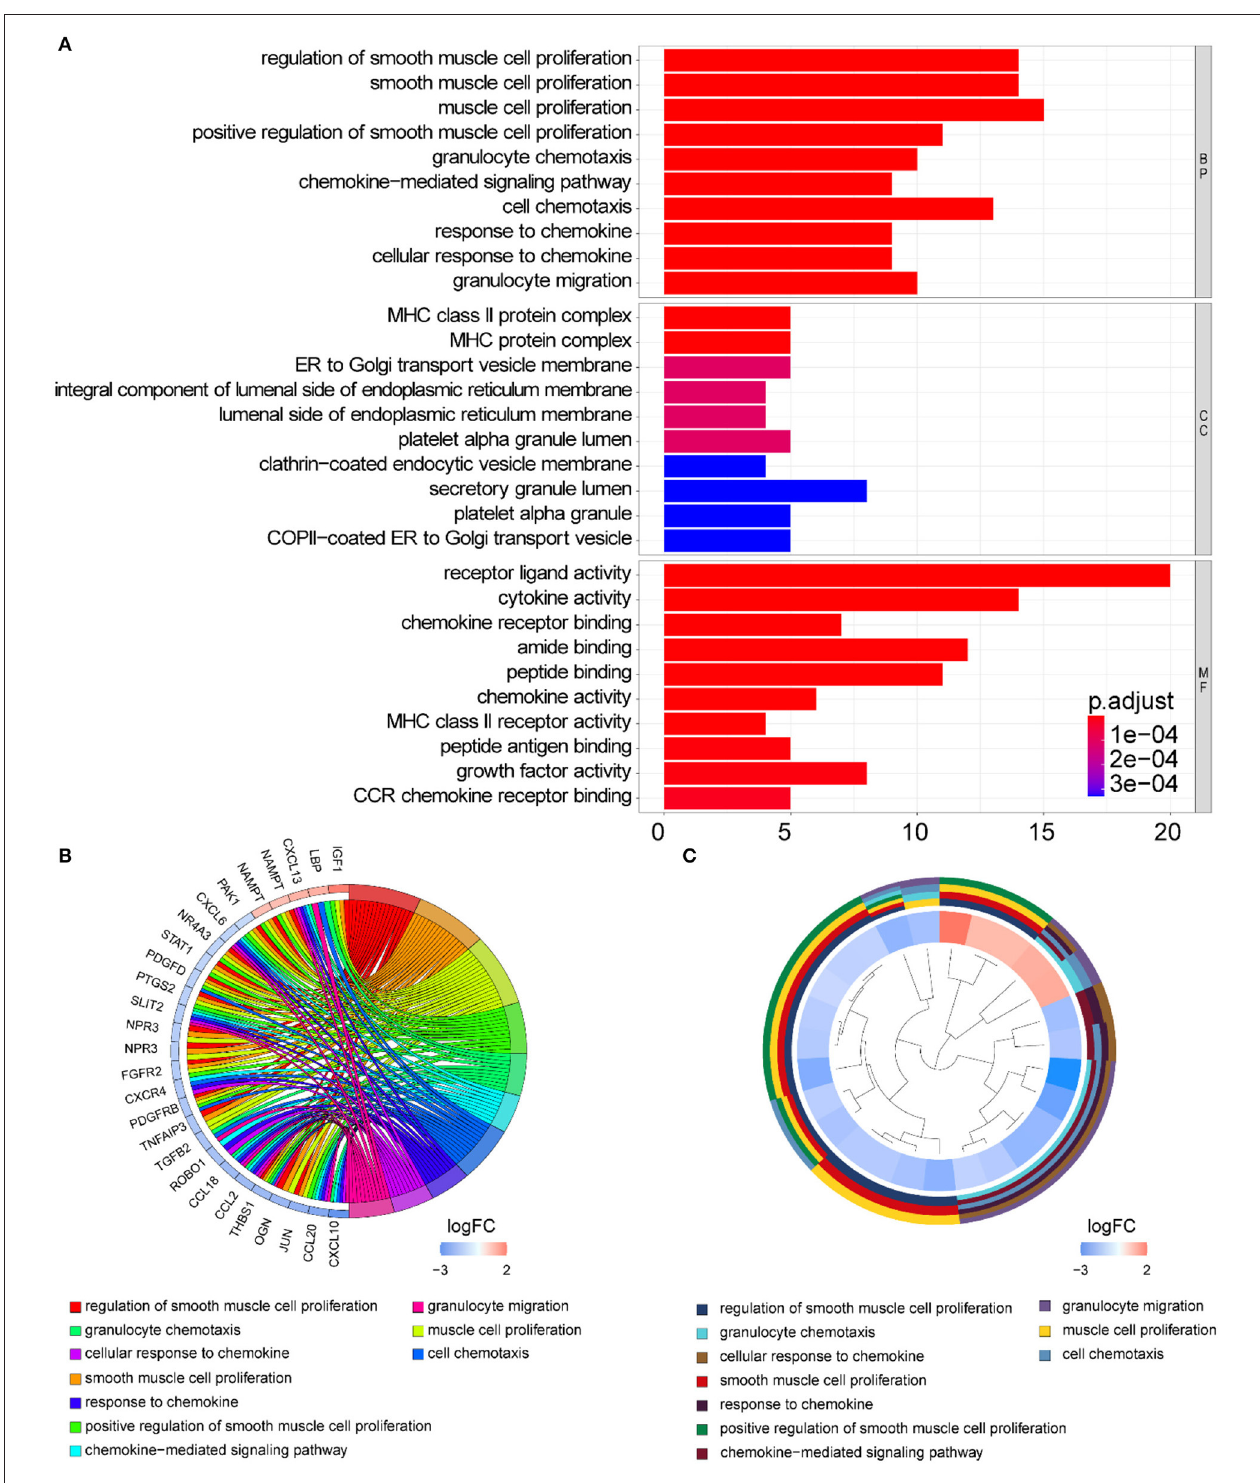
FIGURE 3 | GO analysis of the DE-IGs between normal liver and BA. (A) The 10 most significantly enriched GO terms are displayed in the barplot. The length of the bar represents the number of genes enriched, and the color represents the correlation. BP, biological process; CC, cellular component; MF, molecular function. (B) GO chord diagram of the DE-IGs. The outer circle represents different genes and GO terms. The color depth of the outer circle of genes represents the logFC indicating the gene expression level. The internal colorful ribbon represents the different GO terms the genes enriched. (C) The GO cluster of the DE-IGs. The outer circle represents the GO terms the genes enriched, and the inner circle represents the logFC of each gene, with the color depth corresponding to the gene expression level.